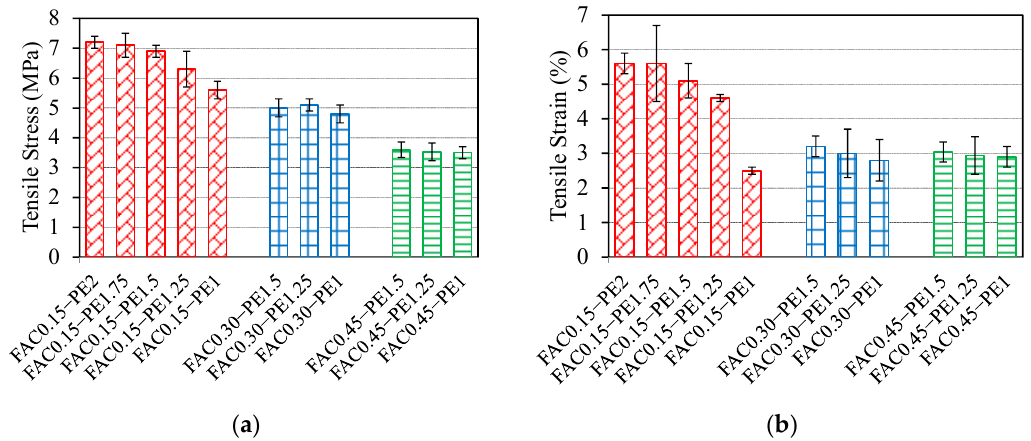
Figure 15. Tensile performances of GLECC mixtures. ( a ) Tensile stress; ( b ) tensile strain.